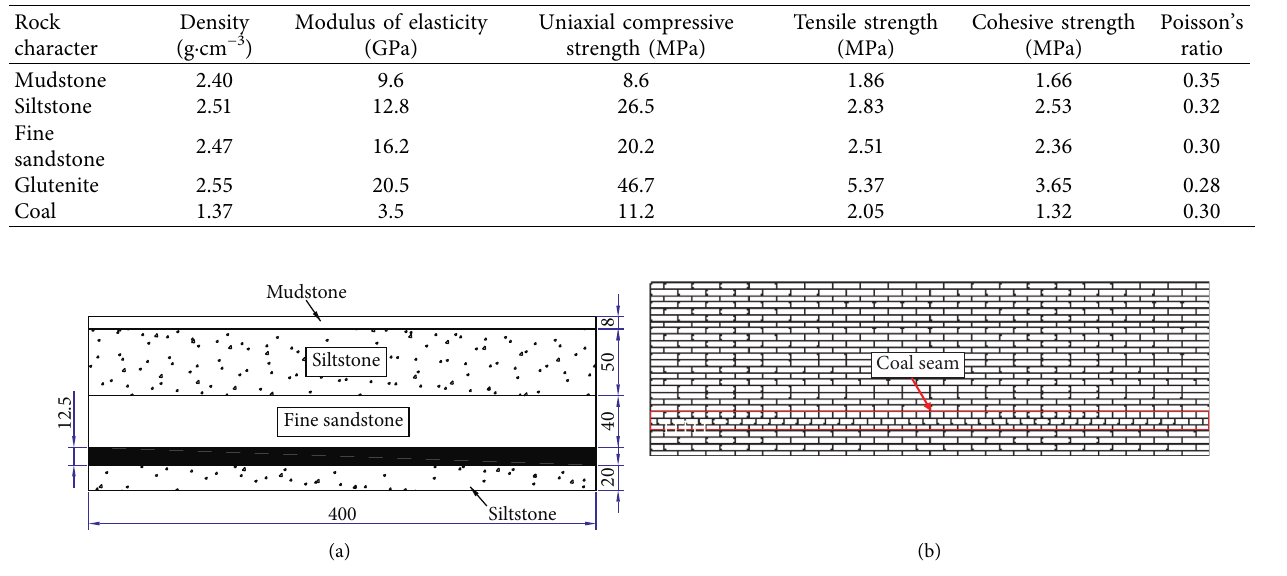
Table 1: Mechanical parameters of coal and rock.